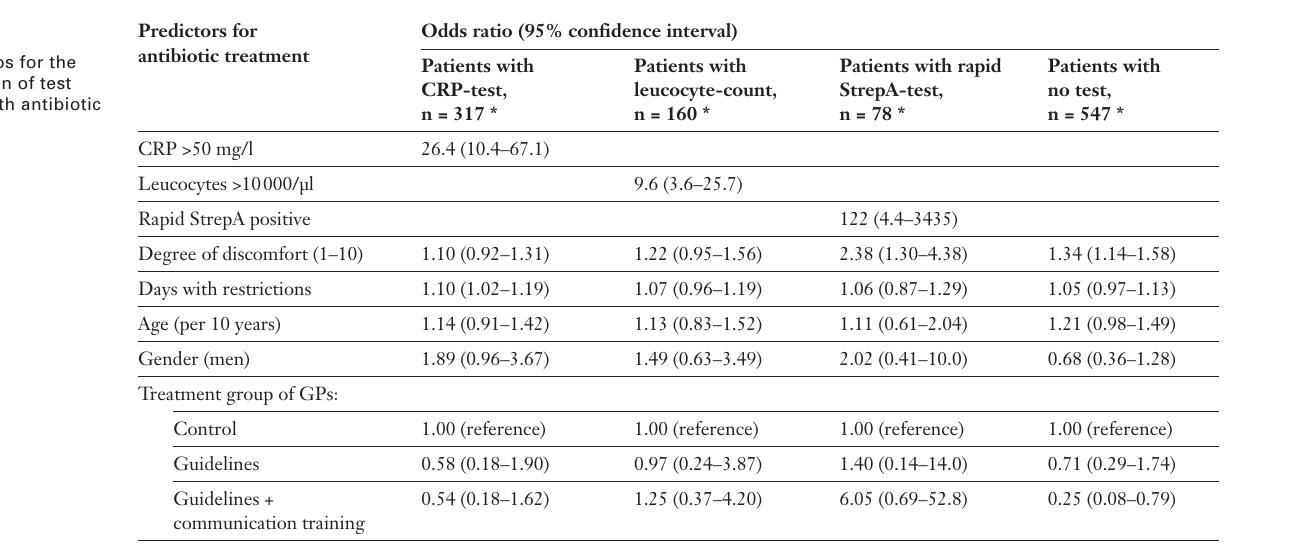
Odds ratios for the association of test results with antibiotic